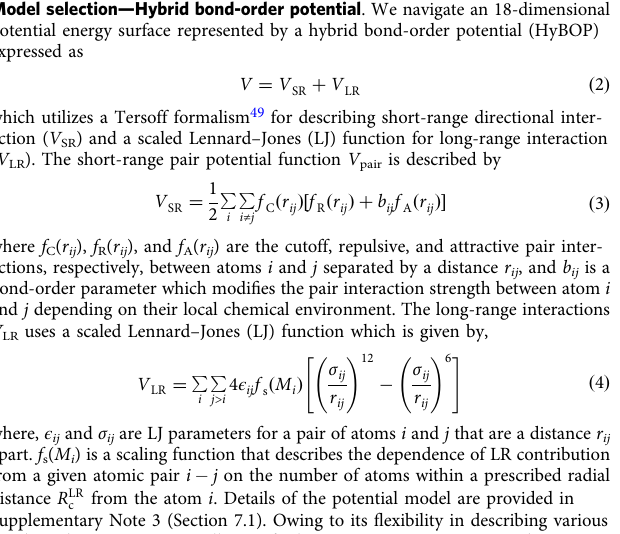
Table 1 and the convergence to solution for representative cases is shown in Supplementary Fig.